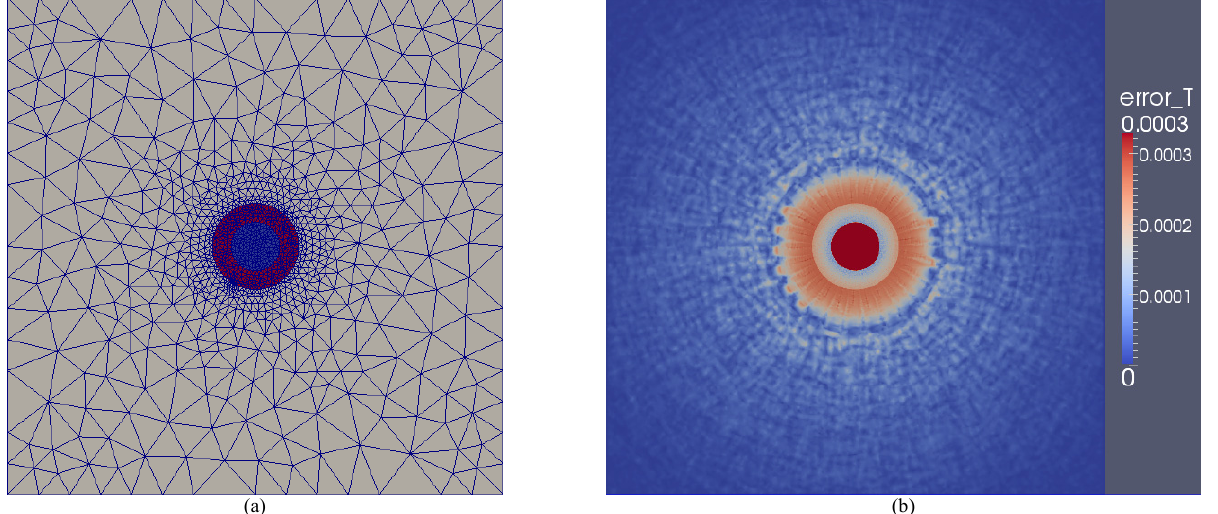
Fig. 10. Calculations with N = 435472 and the mesh topology: (a) mesh topology, (b)